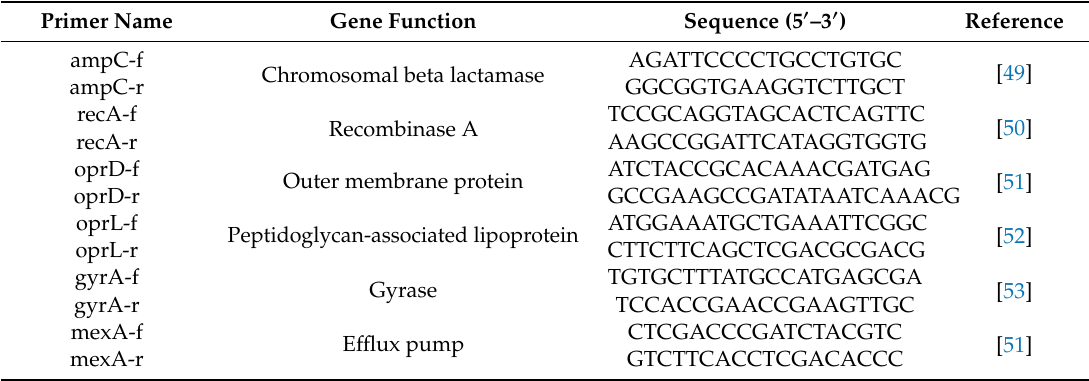
Table 2. Genes and primers that were used in this